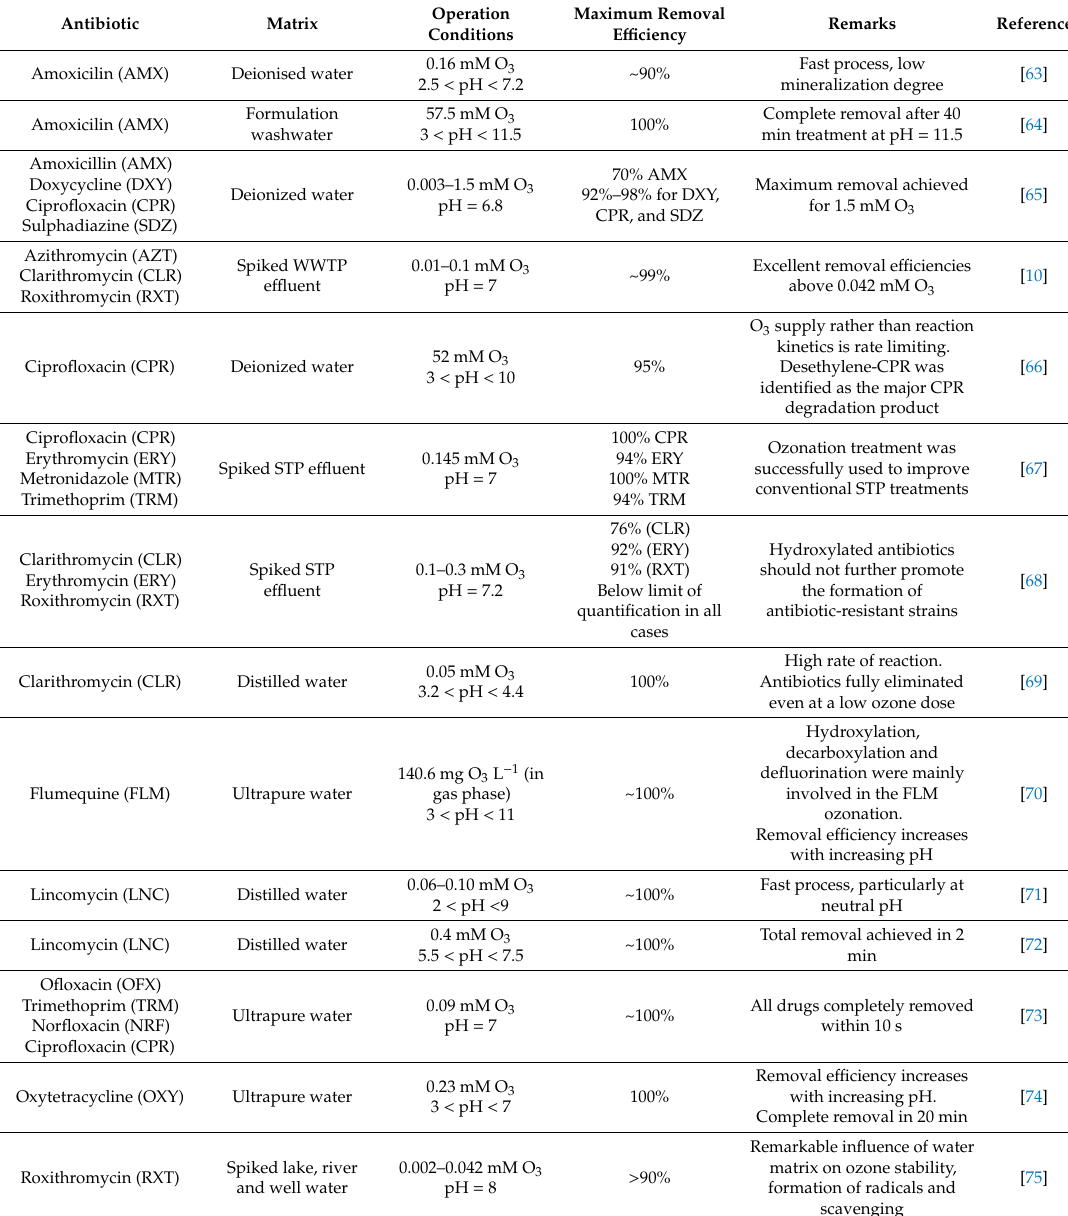
Table 5. Removal e ffi ciency of antibiotics in waters by